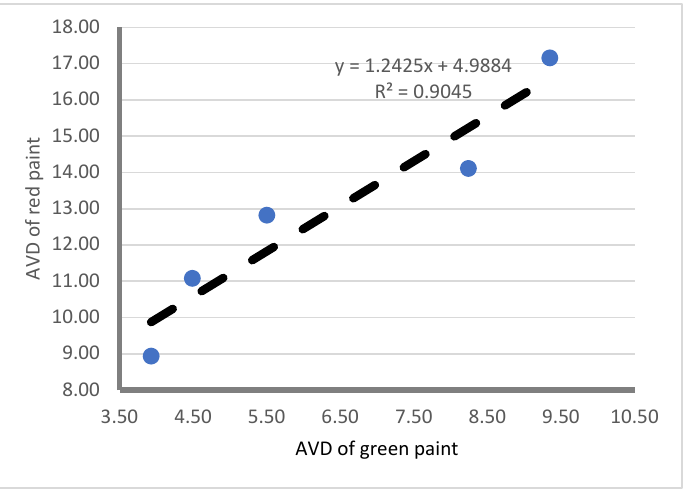
AVD of green paint Figure 7. Correlation between AVD values of IR laser illumination of green and red paint. By contrast, in Figure 8, correlations between the DLS signals acquired from red and green paints using the red laser were much reduced. This could indicate that the red laser has different absorption properties for the red and green paints; the DLS analysis obtained from a very low signal in the case of the green paint provided a void result. That could help the understanding of the influence of chlorophyl in DLS outcomes from using red lasers in vegetable tissues [36–38].